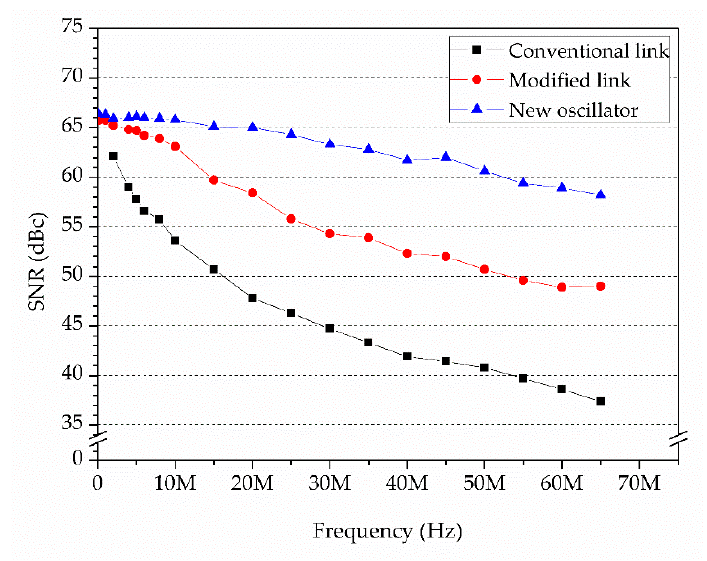
Figure 9. Signal-to-noise ratio (SNR) of the Figure 9. Signal ‐ to ‐ noise ratio (SNR) of the ADC.